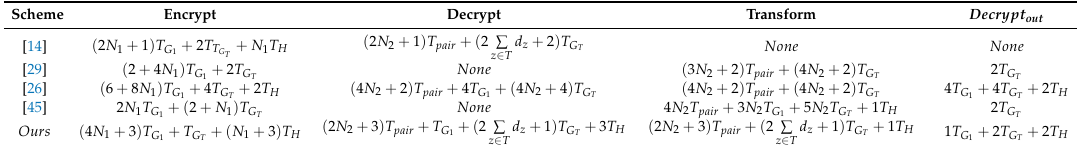
Table 2. Comparison of computation complexity.